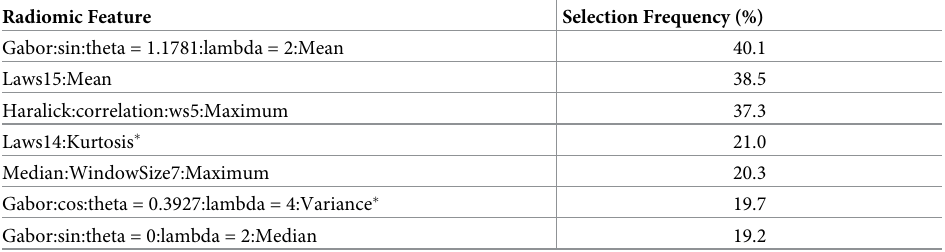
Table 4. Selected radiomic features. (cid:3) Features significantly correlated on the independent validation dataset. Radiomic